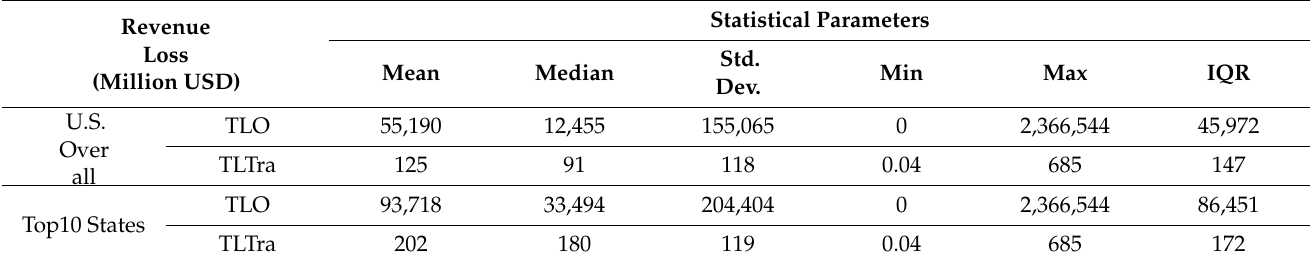
Table 2. Statistical analysis of the total revenue loss for top 10 states and the U.S. overall.